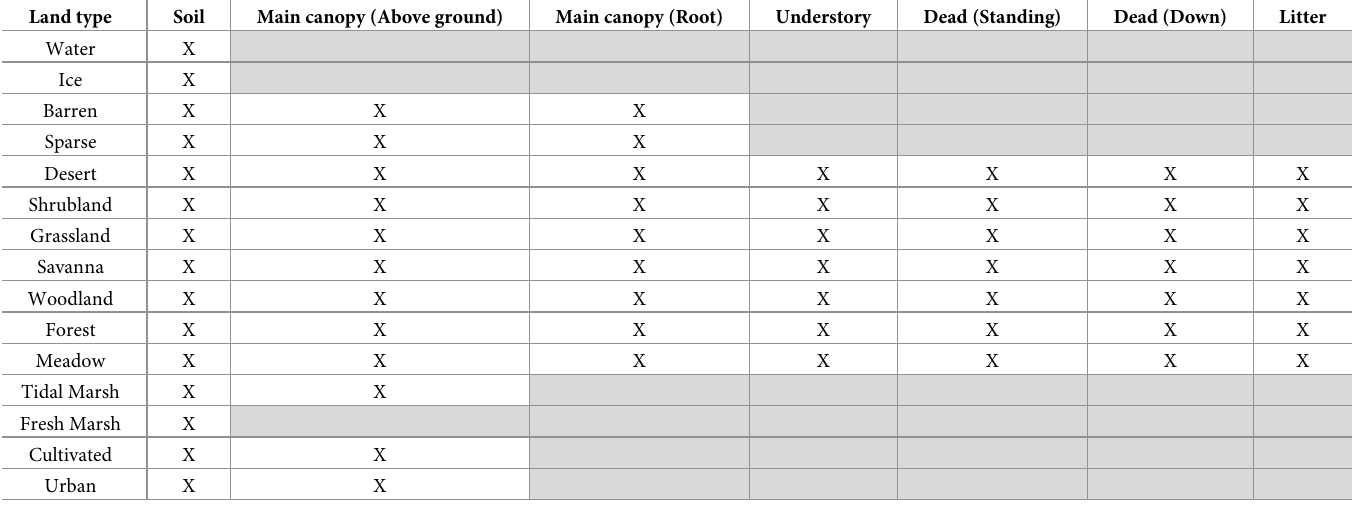
Fig 2. CALAND initial 2010 land type distribution (shading) and region (white lines) boundaries for California. This map was made using GRASS GIS 7.4.1. https://doi.org/10.1371/journal.pone.0251346.g002 detailed description in the technical documentation [14] for additional details on CALAND’s parameterization. Key interactions include management effects on land cover, wildfire sever- ity, forest mortality, and ecosystem carbon exchange; climate effects on ecosystem carbon exchange and wildfire area; wildfire effects on ecosystem carbon density and forest area; and competition for land among prescribed management practices under ongoing LULCC. Fluxes of carbon are speciated into CO , CH , and BC as appropriate, with 100-year global warming 2 4 (as in this study) to treat BC as CO for global warming potential in CALAND because 2 Table 2. CALAND carbon